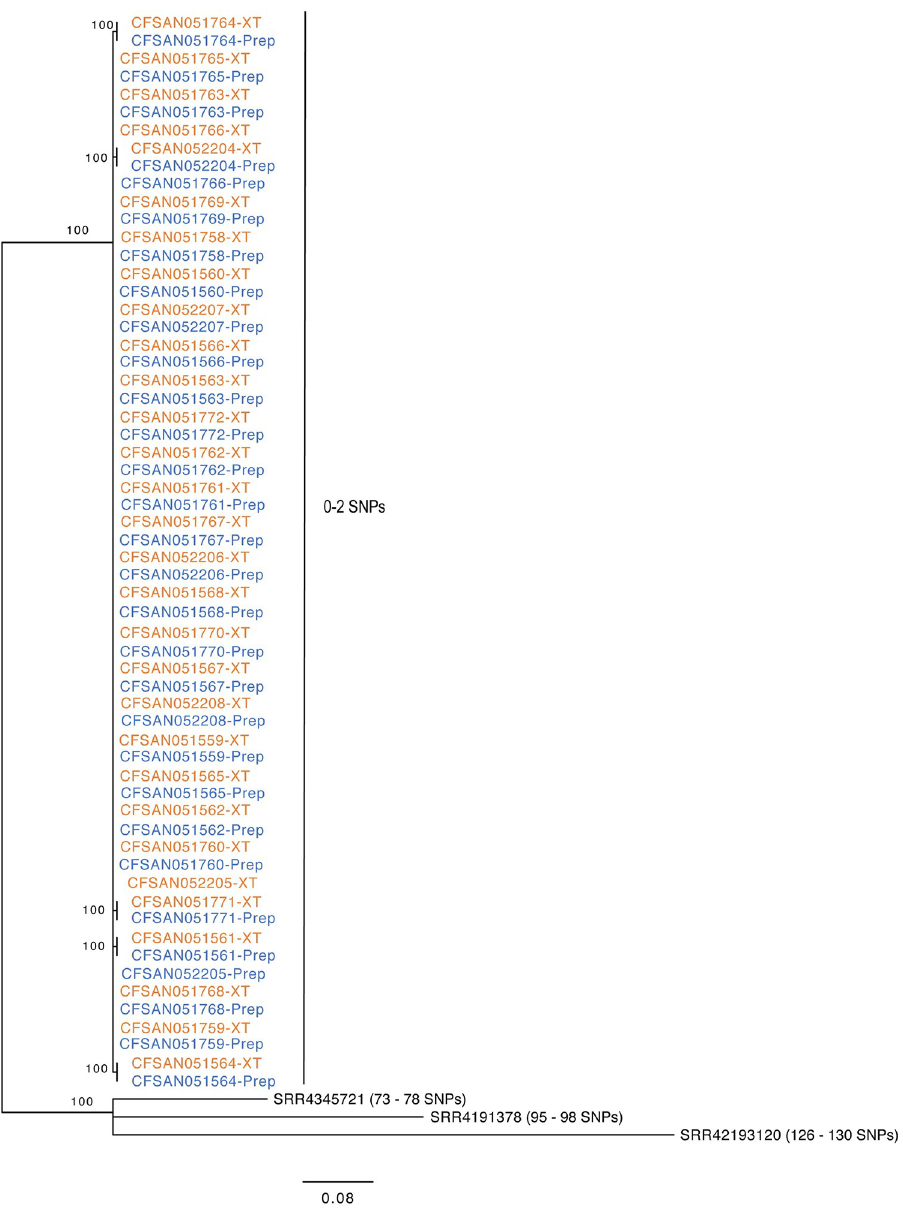
Fig 4. Phylogenetic tree obtained by a maximum-Likelihood analysis of the resultant SNP matrix from the CFSAN SNP pipeline of the data from the 30 strains obtained from each DNA library kit. Results obtained with the XT libraries are shown in red while DNA Prep libraries are show in blue. The genome of FNW19M81 was used as the